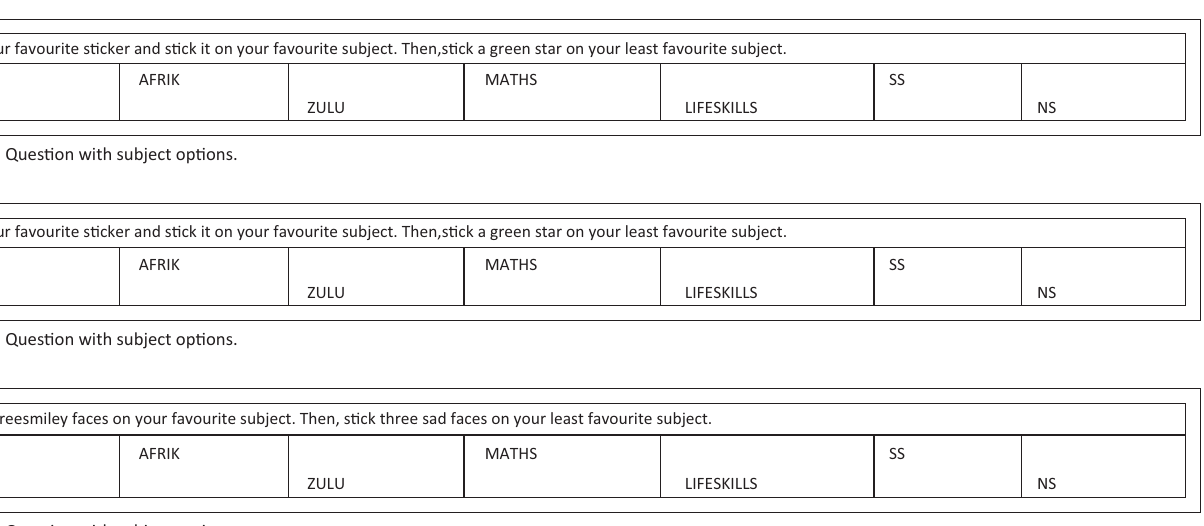
FIGURE 4: Question with subject